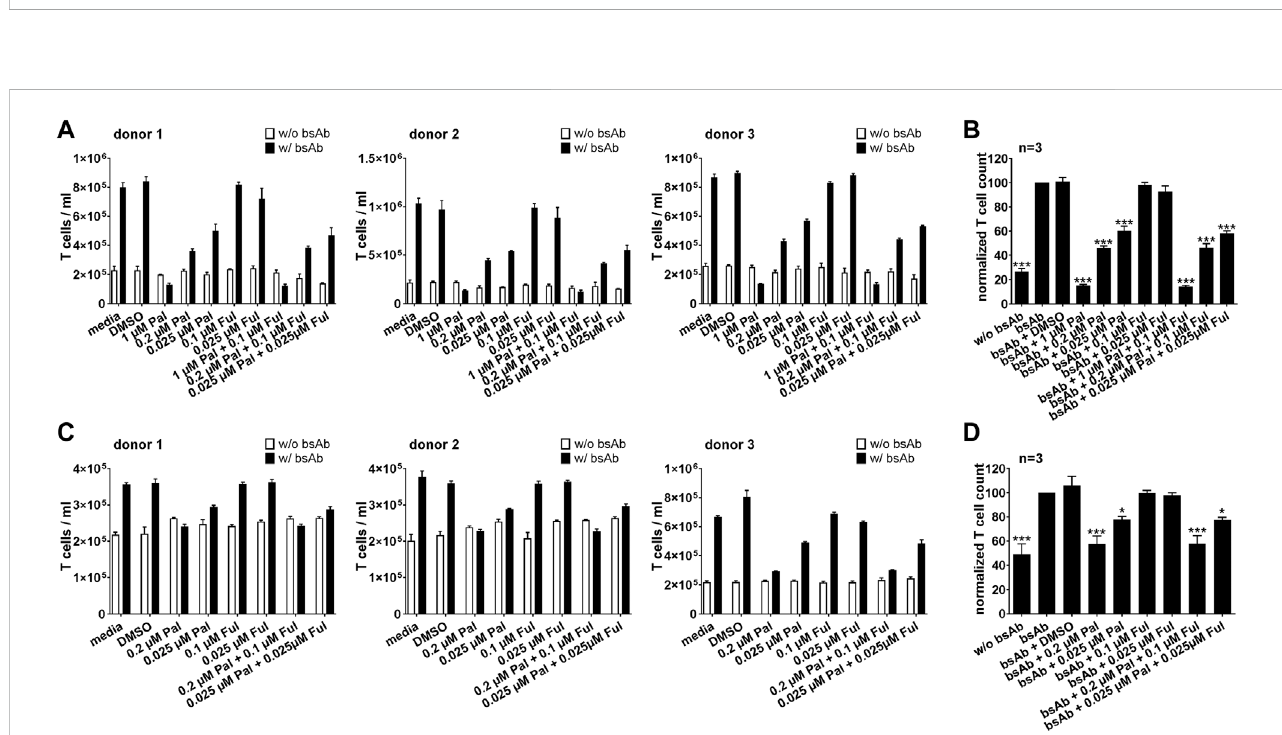
Effect of palbociclib and fulvestrant on bsAb-mediated T cell expansion. eFluor ™ 670 + T cells and (A,B) PC3-PSCA/PSMA Luc+ or (C,D) LNCaP-PSCA Luc+ cells were incubated with or without CD3-PSCA bsAb. Palbociclib and/or fulvestrant were added at indicated concentrations. After 96 h, numbers of eFluor ™ 670 + T cells were determined by fl ow cytometry using the MACSQuant ® Analyzer. (A,C) Each diagram shows average T cell counts ± SEM of triplicates for one T cell donor. (B,D) Graphs summarize relative T cell counts ± SEM of three different T cell donors. T cell numbers in the presence of tumor cells and bsAb ( “ bsAb ” ) were equalized to 100%. (* p ≤ 0.05, *** p ≤ 0.001 compared to control sample “ bsAb ” ; One-way ANOVA with posthoc Dunnett multiple comparison